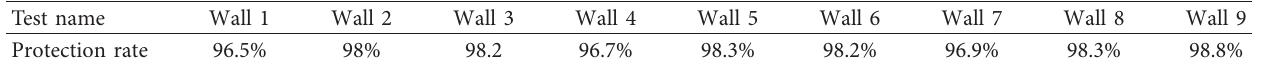
Table 2: Protection ratios of various walls.